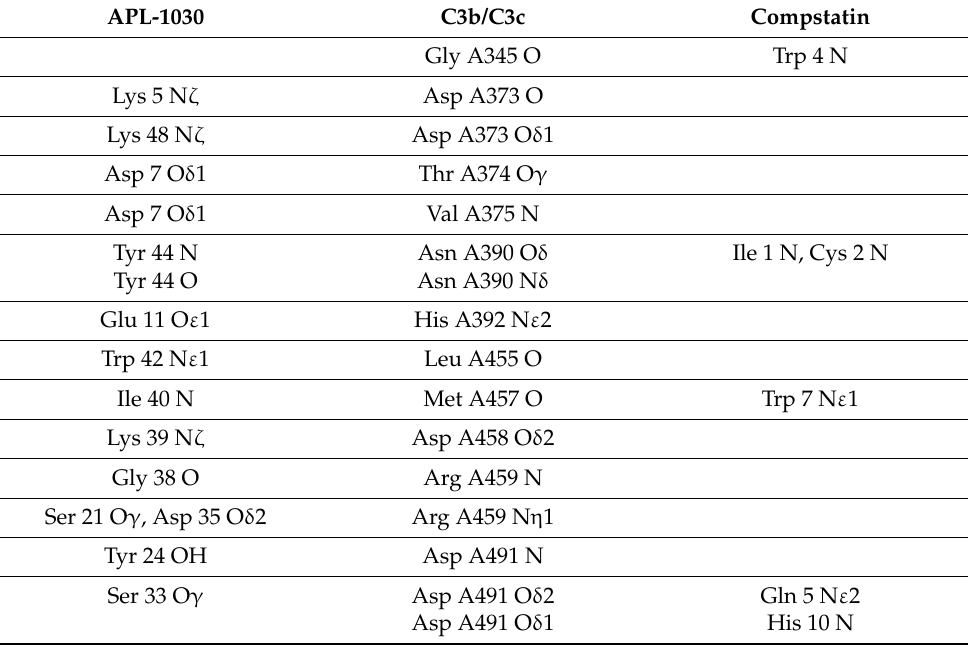
Table 2. Comparison of Protein/Peptide Hydrogen Bonds of C3b/APL-1030 with